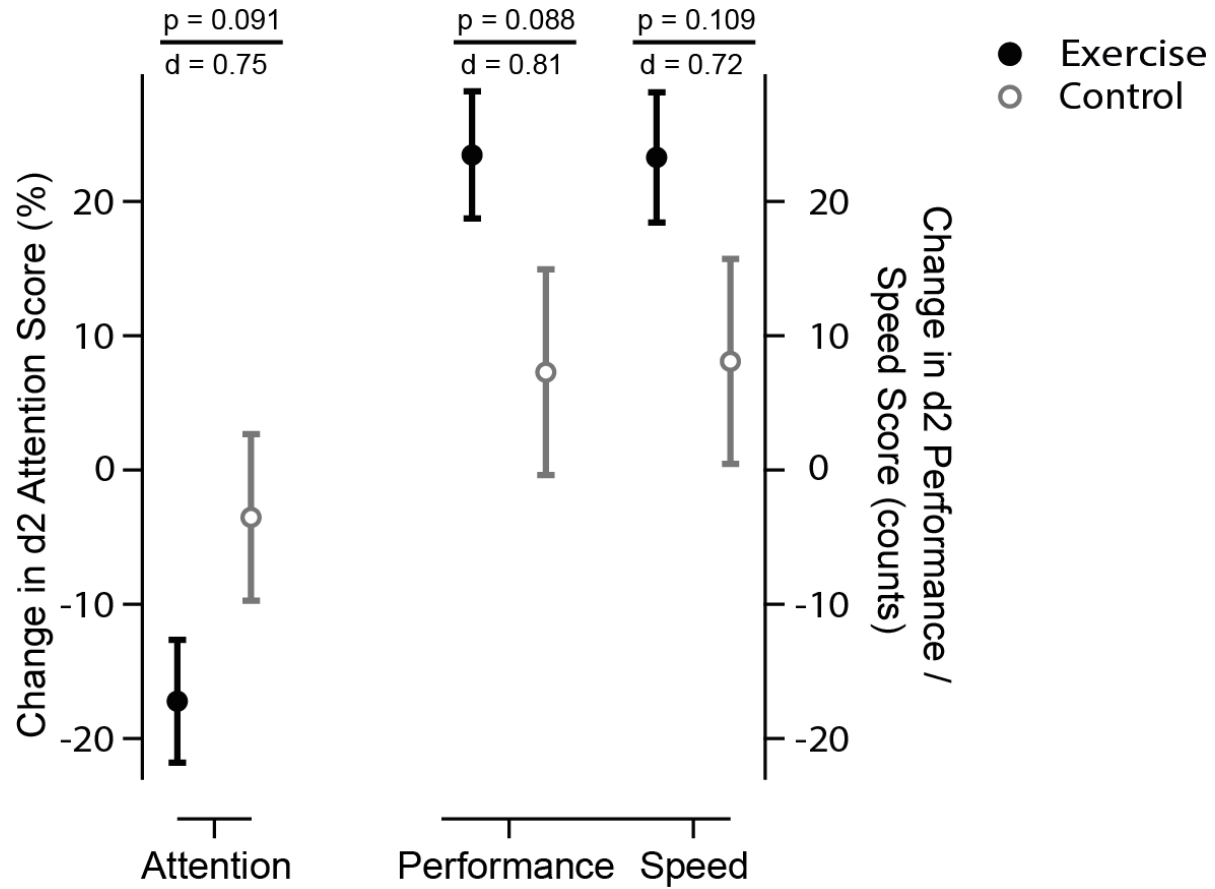
Figure 2. Selective and sustained attention (D2 Score). The circles display the changes to baseline for exercise (solid black) and control (open grey circles). The D2 test of attention consists of a general attention score and subindices, including concentration performance and performance speed [30]. It consists of a general attention score (total errors per total task, in %), with lower scores indicating higher performance (left scale). Subindices (right scales) include performance speed (total number processed, maximum 299), and concentration performance (speed minus error count), with higher scores indicating improved performance and speed. There is a statistical trend (time x group analysis, p < 0.1) that exercise (solid circles) improved attention (less errors), speed (more numbers processed), and performance (count of processed numbers minus errors) then control (open circles). p indicates the level of significance, d represents the effect size according to Cohen, suggesting that a d = 0.2 represents a ‘small’ effect size, d = 0.5 represents a ‘medium’ effect size and d = 0.8 represents a ‘large’ effect